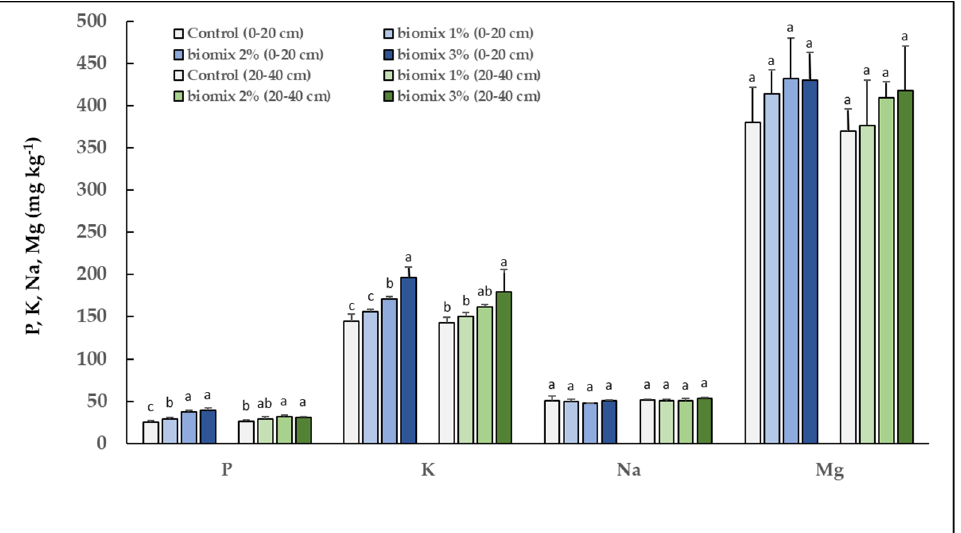
Figure 7. Average P, K, Na and Mg (mg kg − 1 ) concentrations and their standard deviations (SD) of samples of the four treatments at 0 − 20 and 20 − 40 cm depth. Each value is the mean of three replicates. Different letters above each column within the same parameter evaluated, indicate significant differences among treatments.